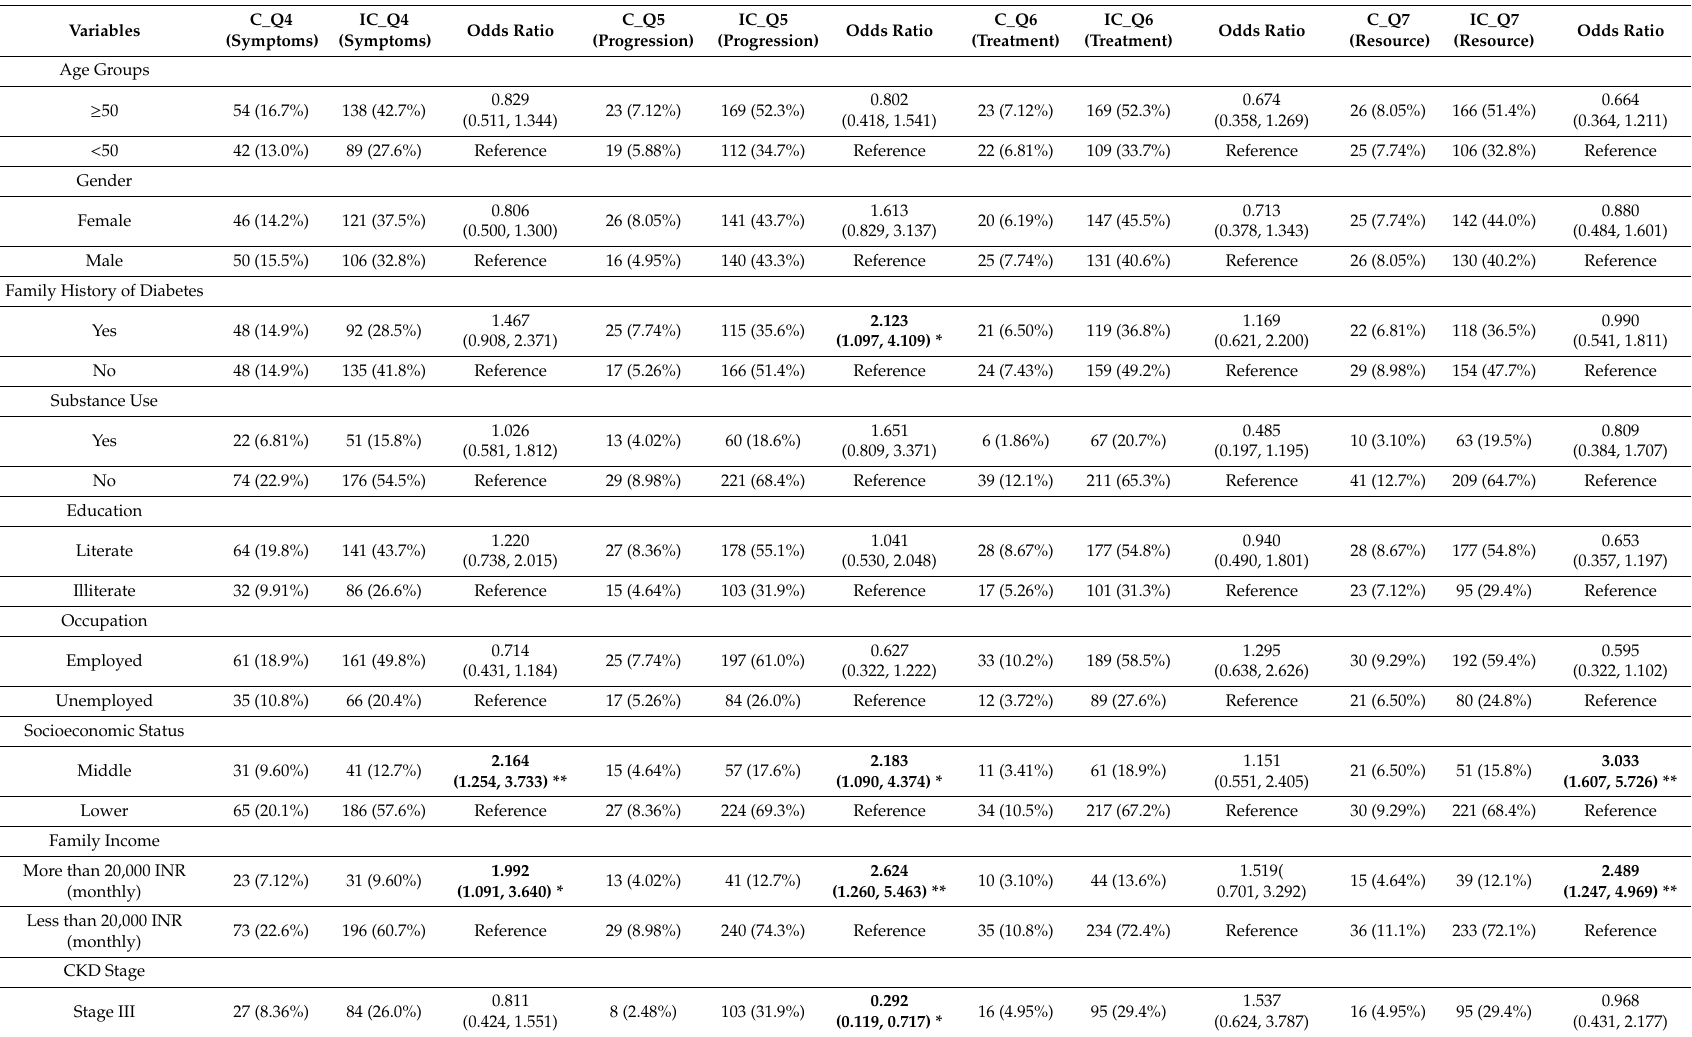
Table 4. Association between di ff erent domains of knowledge and demographic characteristics